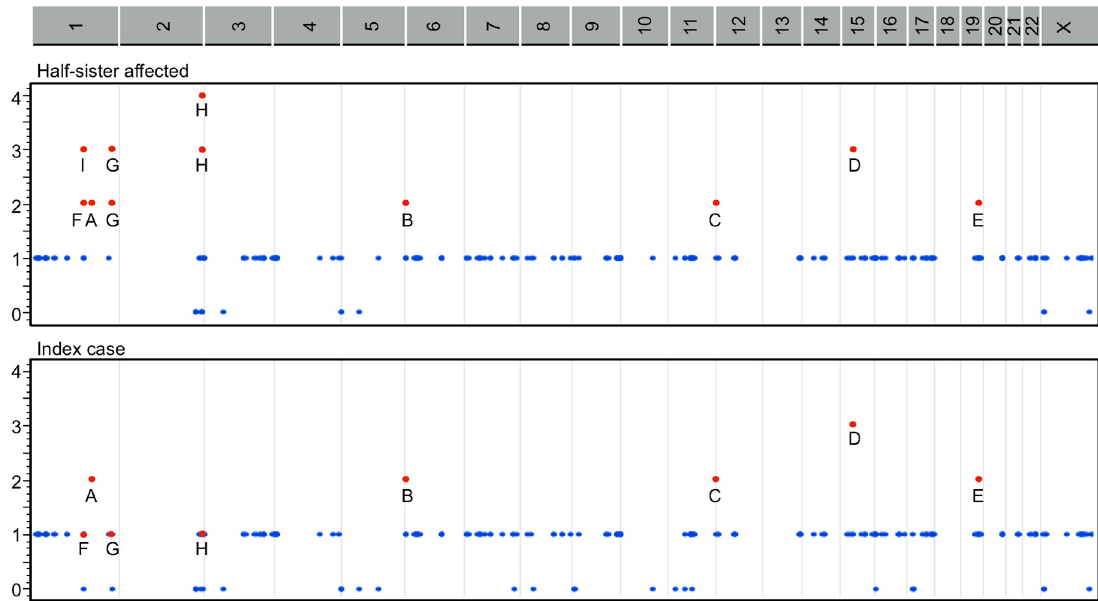
Figure 3. Heterozygous compound model score regions from gene variants identified in F5 ( A ), CDYL ( B ), KDM5A ( C ), RASGRP1 ( D ), MYBPC2 ( E ), PDE4DIP ( F ), OBSCN ( G ), UGT1A ( H ), and 1:144146811–146467744 chromosomal region including PDE4DIP ( I ) among both cases and the mother (significant heterozygous regions as red points). Vertical scales list the number of heterozygous genotypes inherited from the mother. Horizontal scales depict the chromosomal region involved.